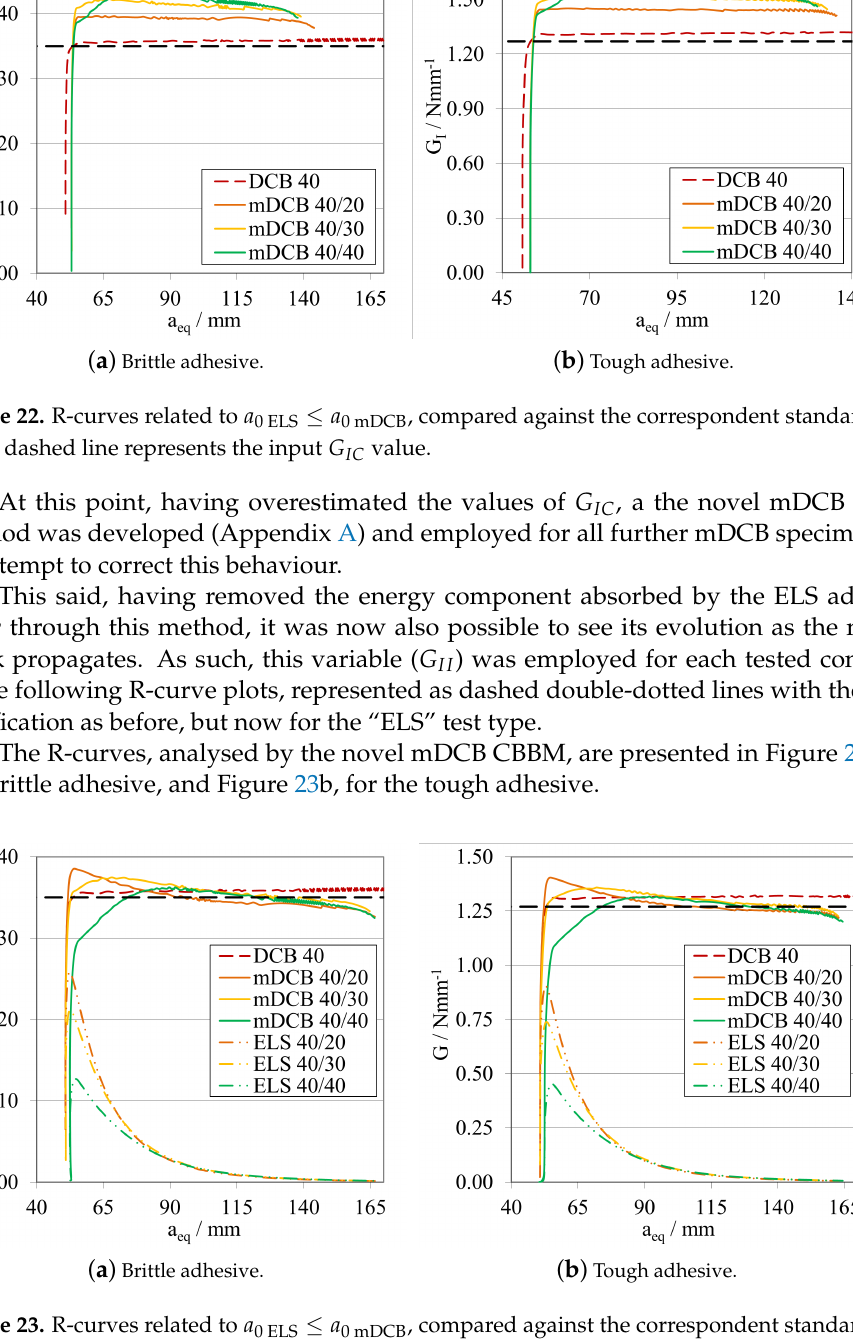
Figure 23. R-curves related to a 0 ELS ≤ a 0 mDCB , compared against the correspondent standard DCB, analysed through the novel mDCB CBBM data reduction scheme. Black dashed line represents the input G IC